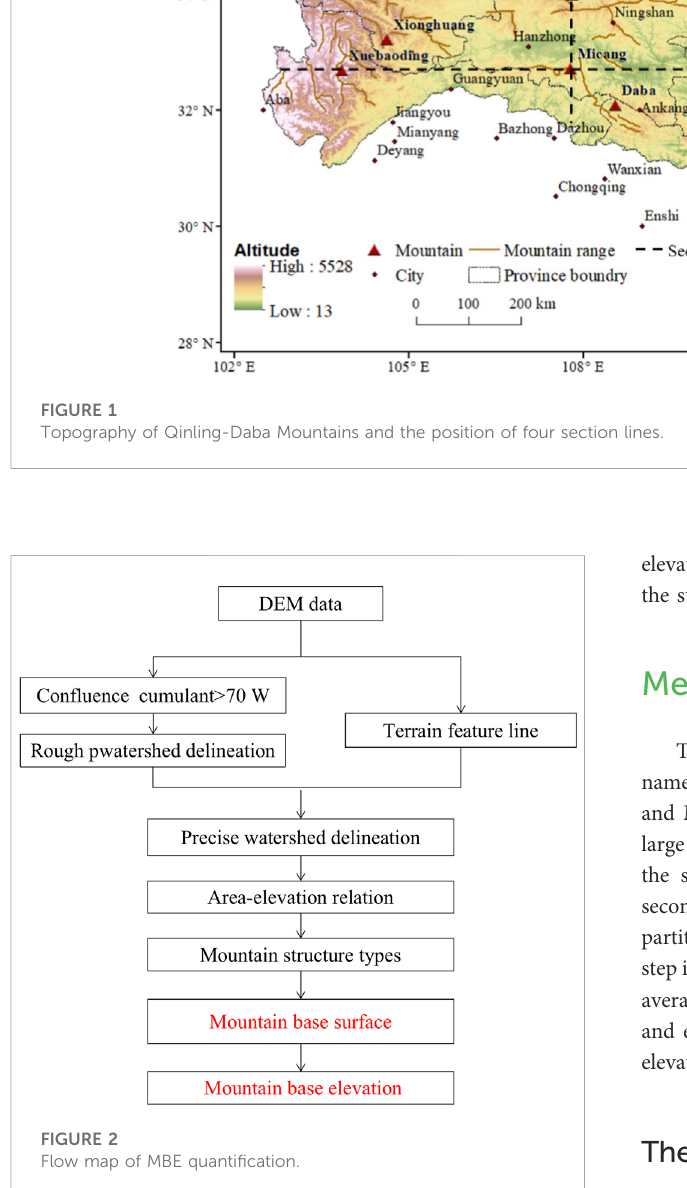
FIGURE 2 Flow map of MBE quanti fi